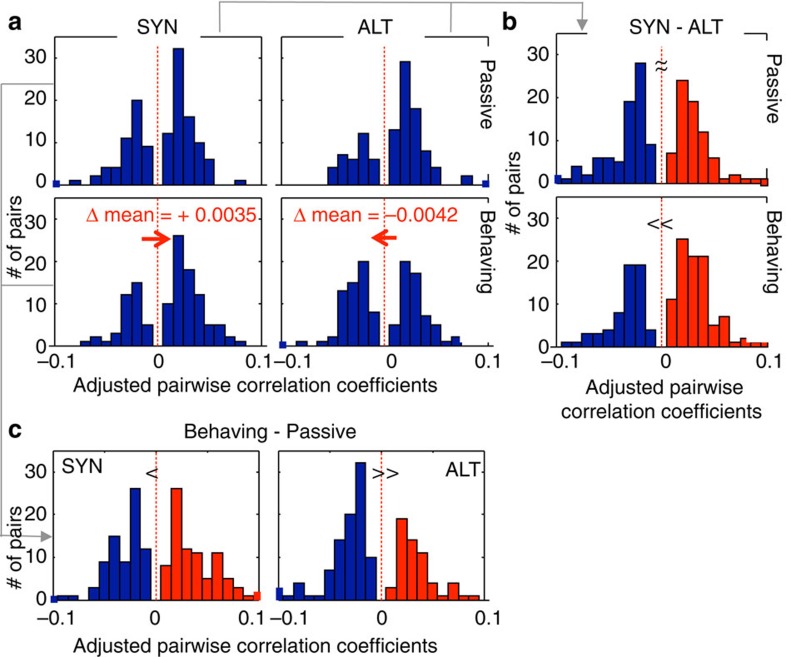
Distributions of adjusted pairwise spiking correlation coefficients in SYN and ALT contexts.(a) Adjusted correlation coefficients (that is, the correlation minus the same measurement after shuffling order of all trials) are shown during passive listening (top panels) and behaviour (bottom panels), in SYN and ALT contexts (left and right). Only non-zero correlation values (absolute value>0.01) were included in these displays, but no data were excluded for statistical analysis. The distributions following SYN and ALT contexts were similar in the passive state. During behaviour, they shift in opposite directions, with SYN becoming slightly more positive, and ALT more negative. (b) Distribution of differences of correlations between SYN and ALT conditions (SYN—ALT). Differences were approximately symmetrically distributed around zero during passive listening (top panel) and significantly biased towards positive values (p<0.004) during behaviour (bottom panel). (c) Distribution of differences of correlation (Behaviour—passive). Differences were significantly biased towards negative values during ALT contexts (P<0.014; right panel), but only marginally shifted towards positive values during SYN contexts.